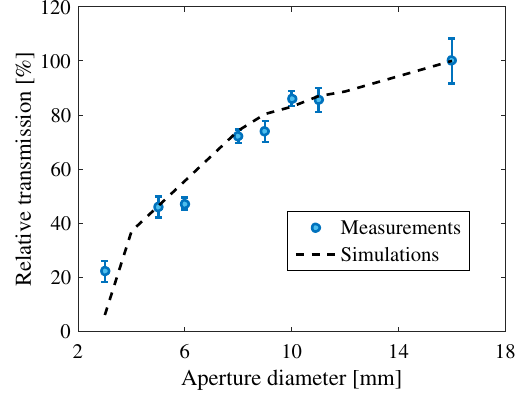
FIG. 20. Measured slice energy spread along the bunch for several collimator apertures compared to the case with the collimator removed from the beam path ( “ Plate out ” ). The full bunch length is divided in 15 parts of constant length.